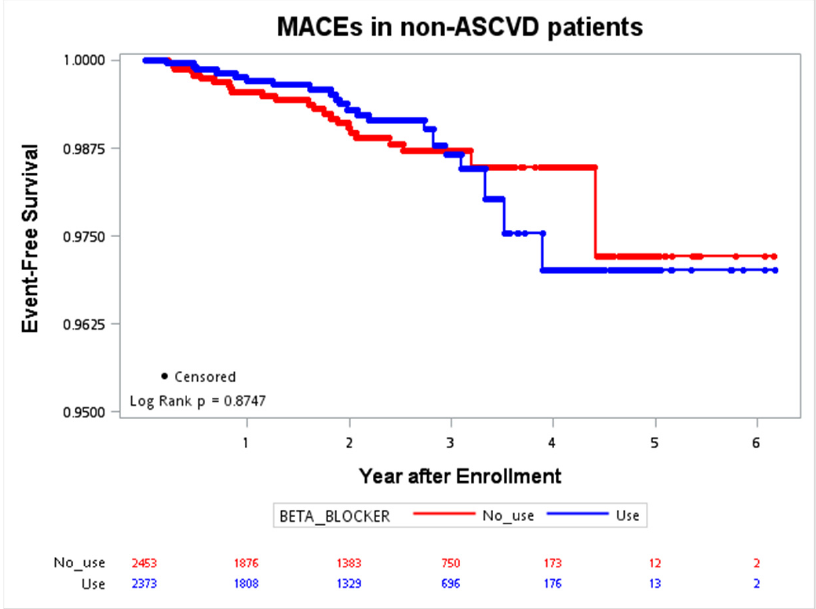
Figure 2. Event-free survival of the MACE (CV death, nonfatal stroke, nonfatal MI, cardiac arrest) in patients without ASCVD. ASCVD, atherosclerotic cardiovascular disease; CV, cardiovascular; MACE, major adverse cardiac event; MI, myocardial infarction.